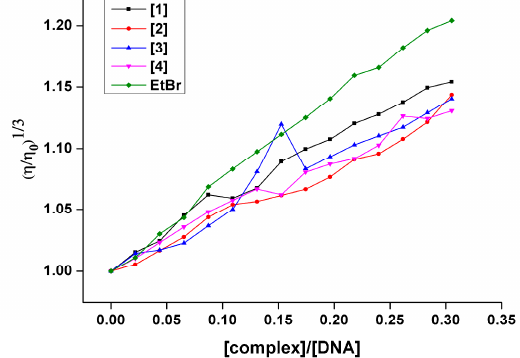
Figure 10. Relative viscosity of DNA in the buffer solution in the presence of studied complexes ( 1–4 ) under the condition of increasing the concentration ratio [complex]/DNA.